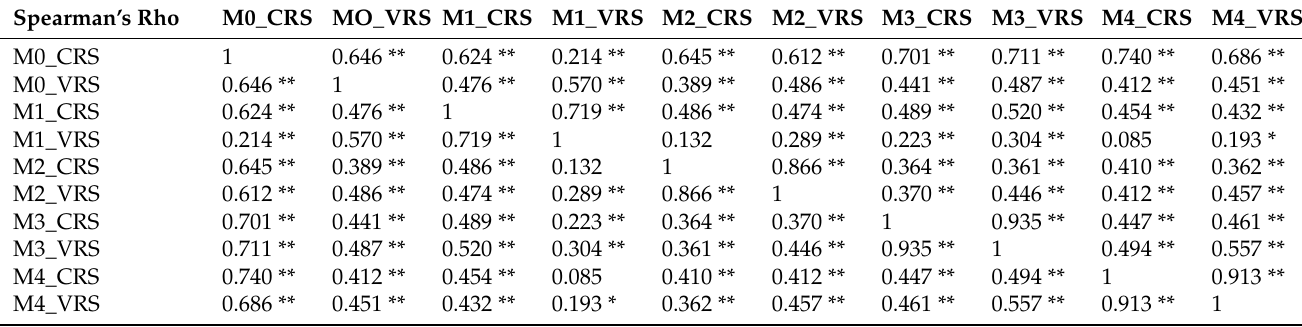
Table 8. Correlation coefficient.